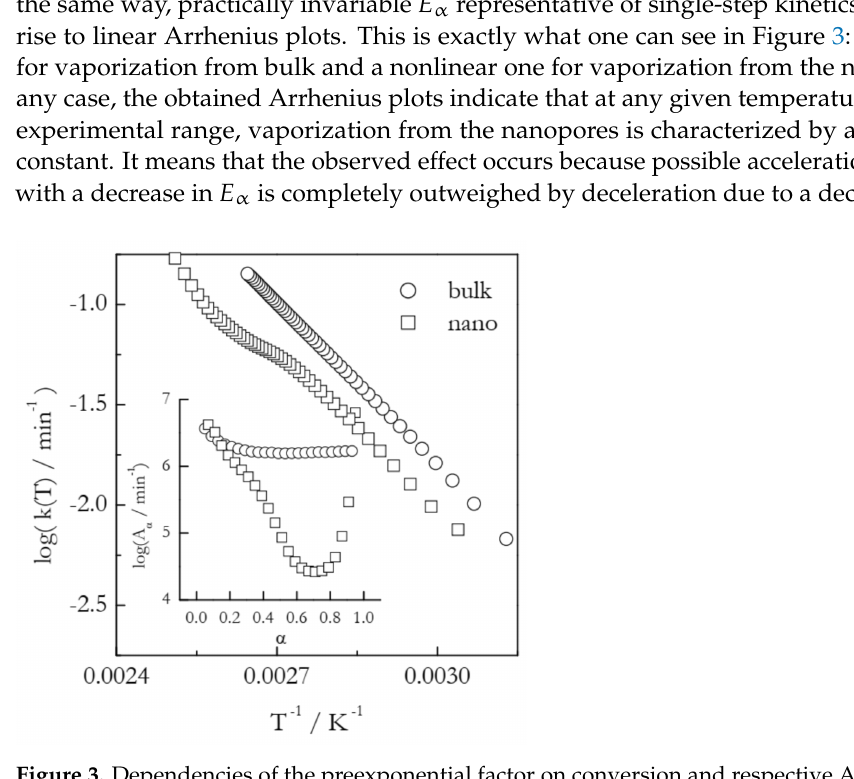
Figure 3. Dependencies of the preexponential factor on conversion and respective Arrhenius plots for vaporization of n -decane from bulk (circles) and nanopores (squares). Adapted with permission from Ekawa et al. [32]. Copyright 2021